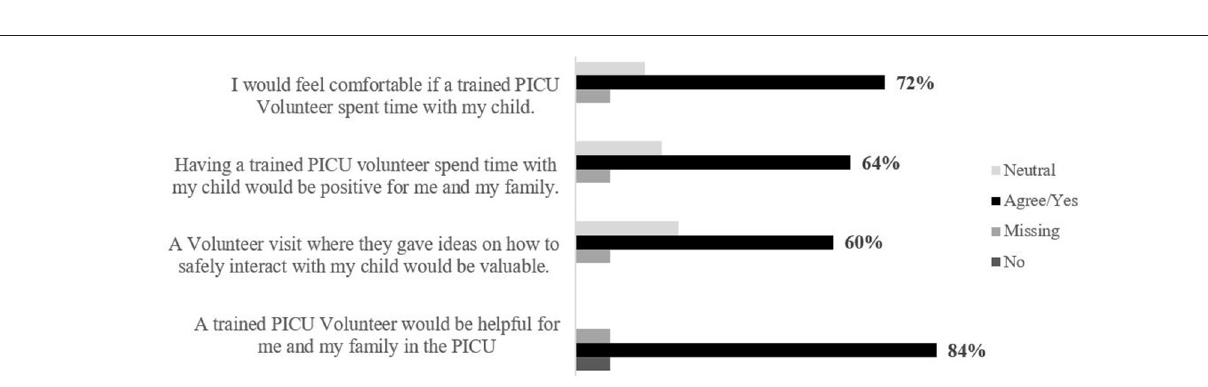
FIGURE 7 | Parent level of agreement on volunteer program benefits